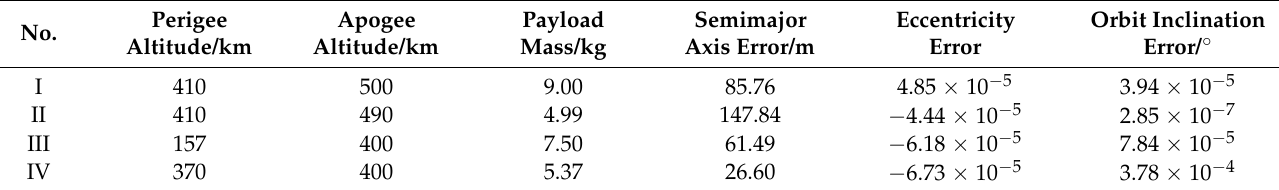
Table 4. Feasibility results of mission decision making and trajectory